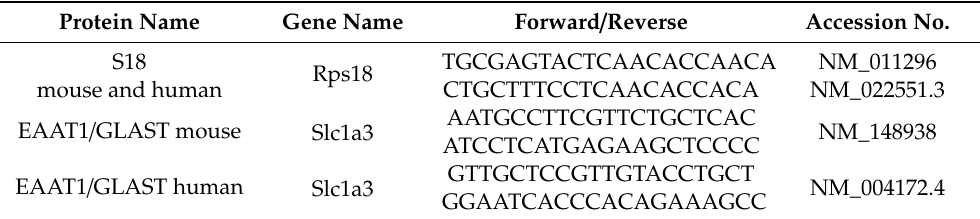
Table 1. List of oligonucleotide primers used for real-time